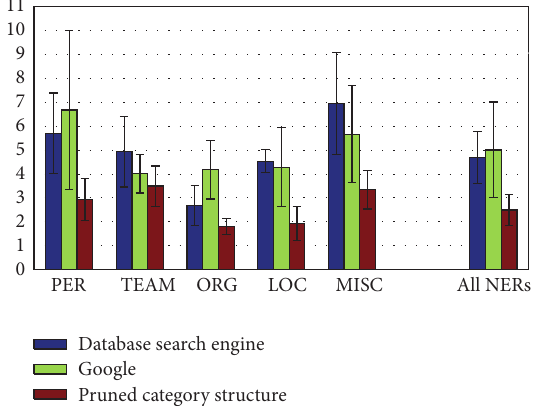
Figure 9: Number of queries actually typed before having a result including the named entity among the first 10 results, by type of named